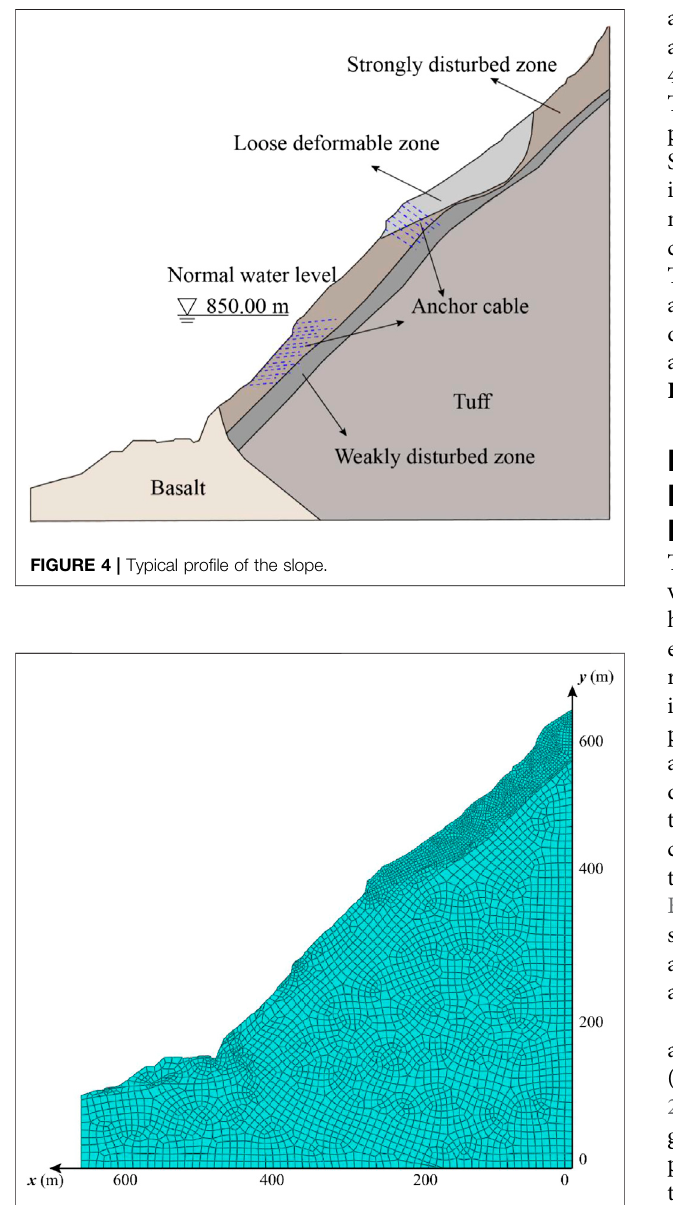
FIGURE 5 | The fi nite element model of the